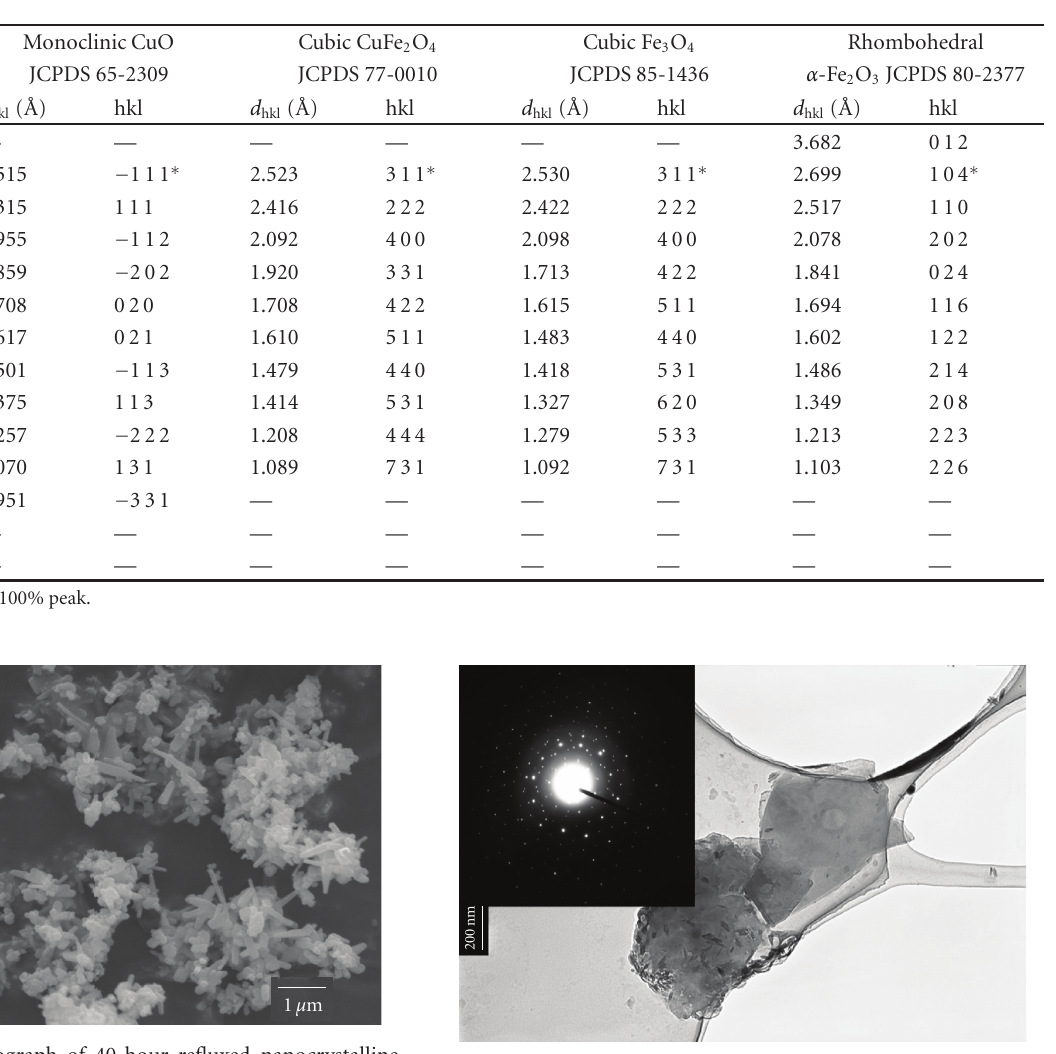
Figure 5: TEM micrograph and SAED pattern of nanocrystalline Cu 0 . 95 Fe 0 . 05 O (900 ◦